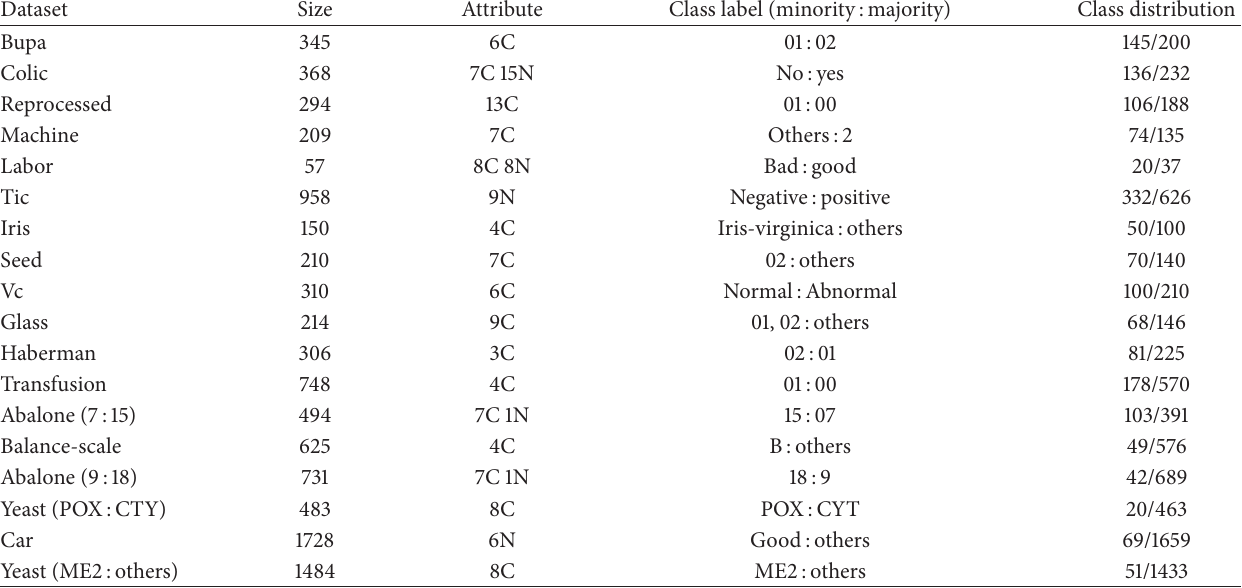
Table 1: Data description.